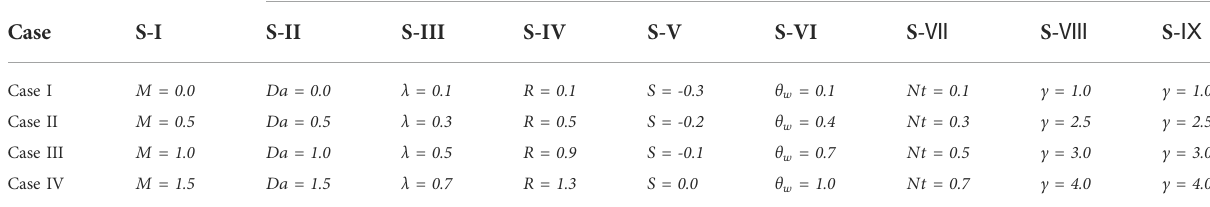
TABLE 2 Variant of